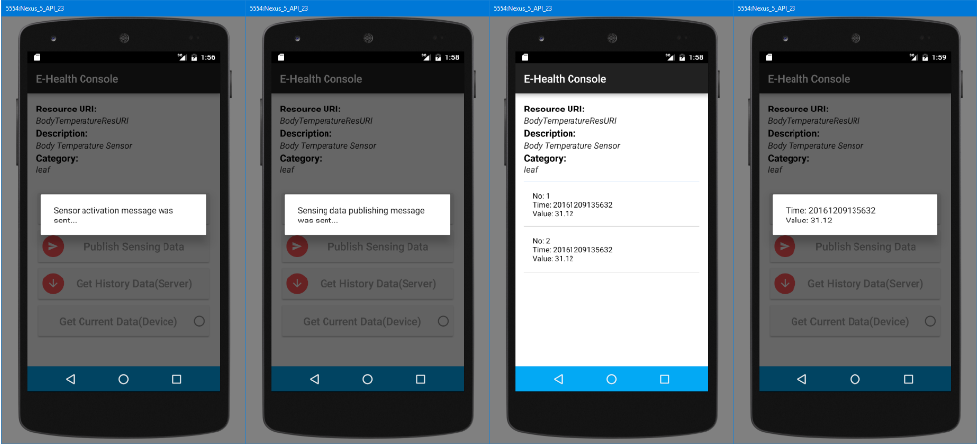
Figure 9. Demonstration screenshots of the e-Health client.